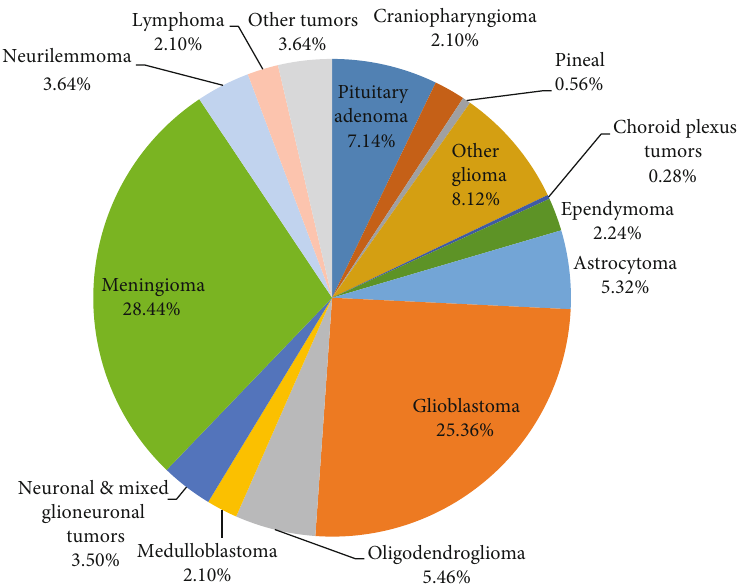
Figure 4: Distribution of all primary CNS tumors by histology diagnosis for adults ( > 18 years).